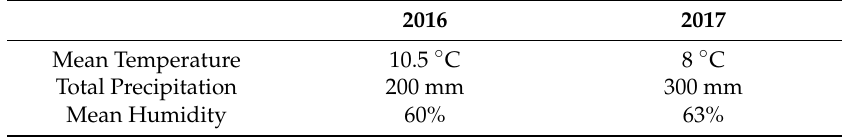
Table 2. Mean temperature, total precipitation, and mean humidity, 2016 and 2017.